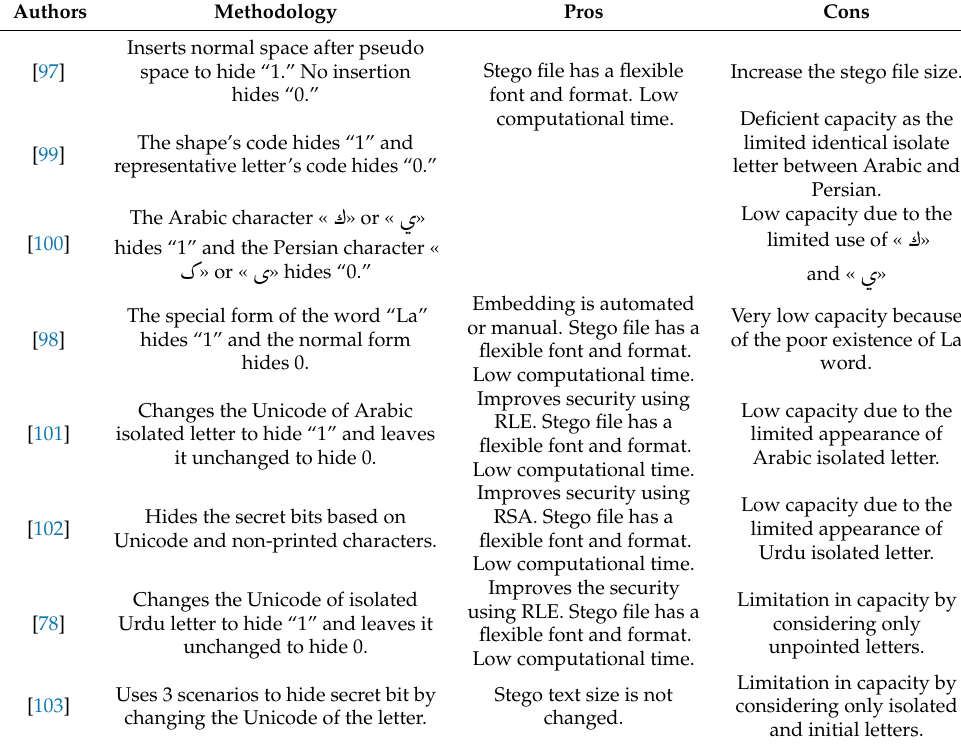
Table 13. A summary of the reviewed articles on the Unicode